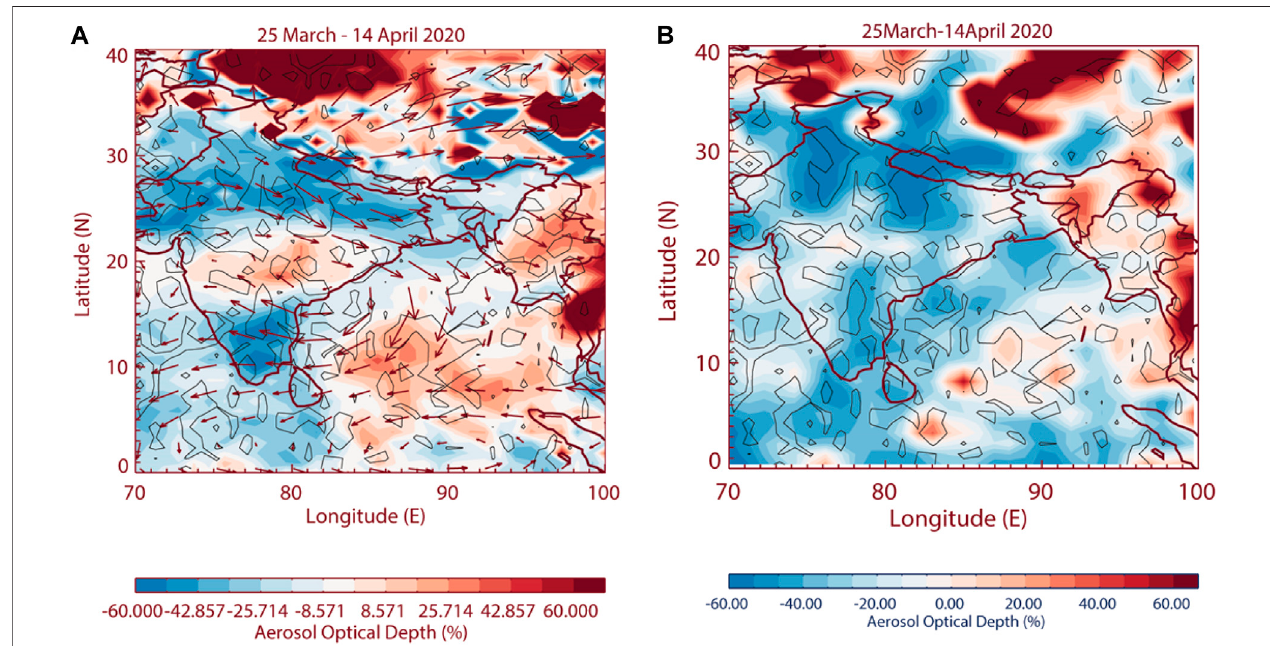
FIGURE 1 | (A) Spatial distribution of changes in AOD (2020-climatology) from MODIS at 550 nm (%) and wind vectors at 850 hPa averaged for the lockdown period (March 25 – April 14, 2020) are also shown in (A) , (B) same as (A) but changes in AOD (2020-climatology) from CALIPSO at 532 nm. Contours in Panels (A,B) indicate 90% signi fi cance